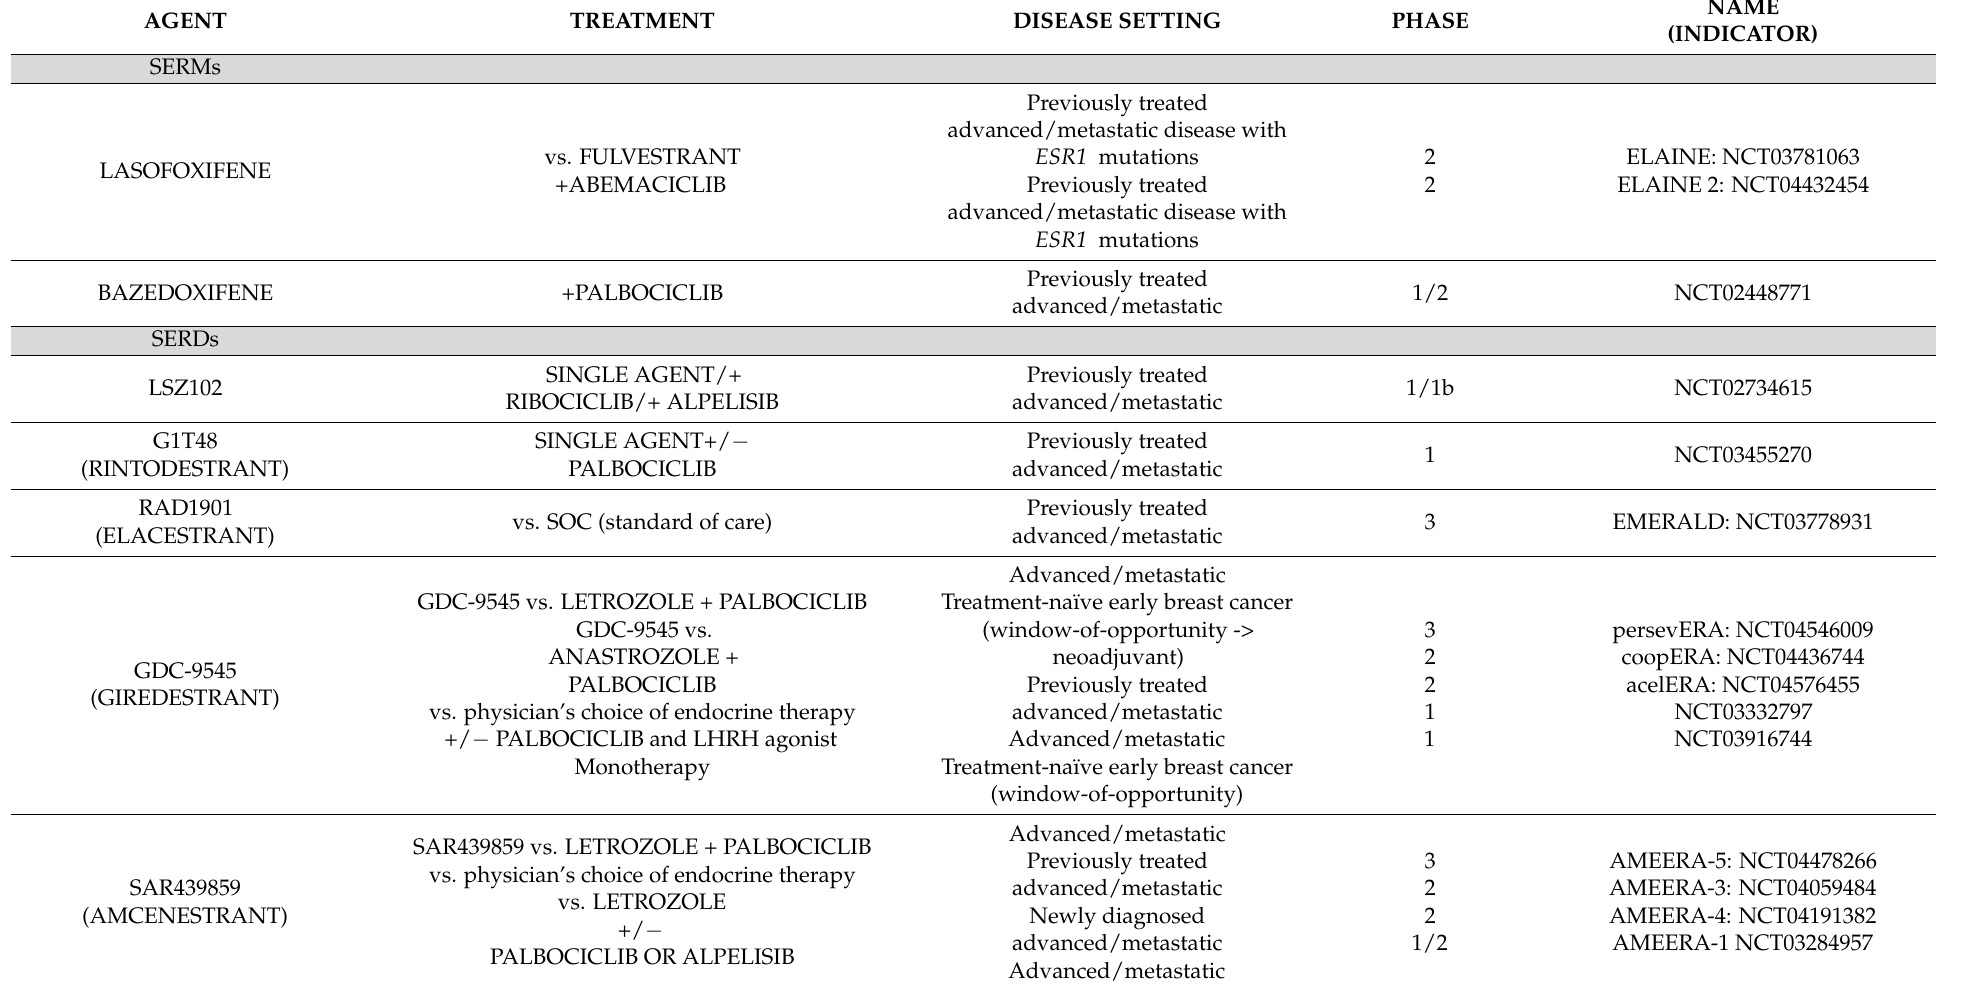
Table 1. Ongoing Trials: Numerous nonsteroidal SERDs are now being studied in clinical trials. Here we summarize the orally available SERDs currently in clinical